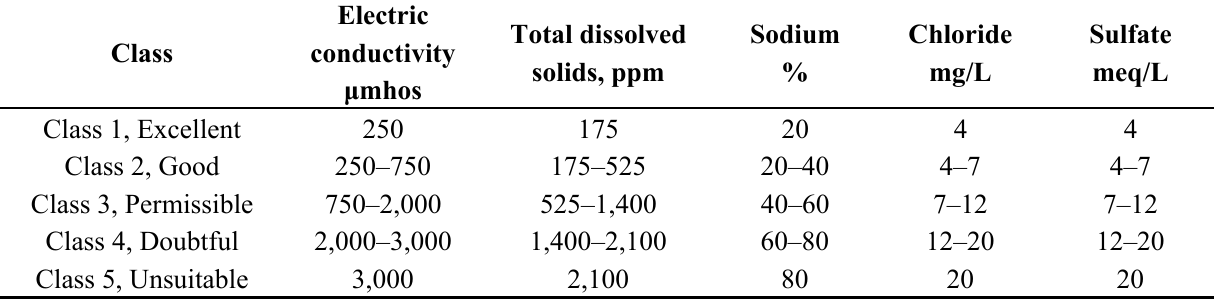
Table 2. Permissible limits for classes of irrigation water [24,25].